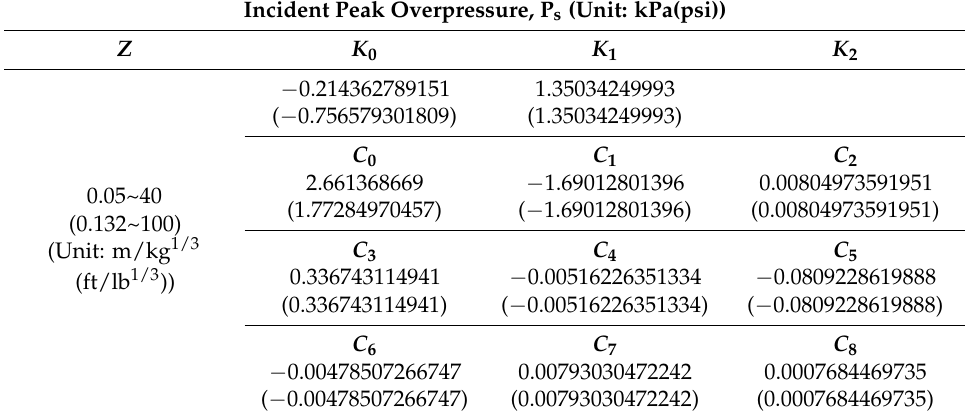
Constants for the Incident Peak Overpressure (Kingery-Bulmash Equation for a Free-Air Burst)